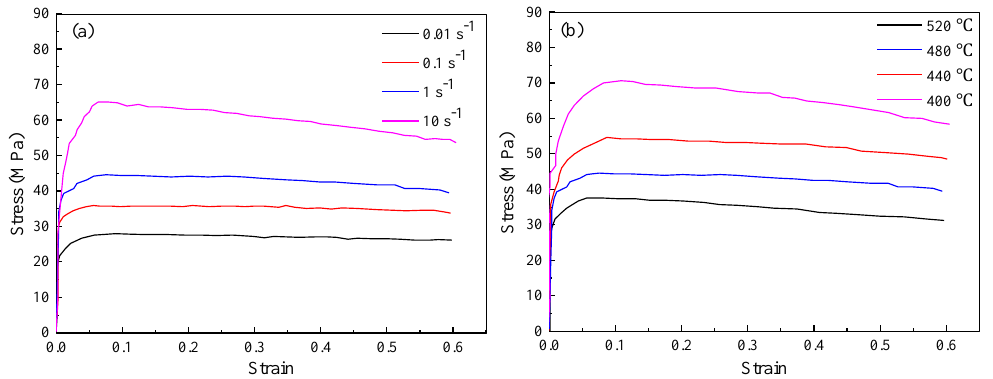
Figure 4. True stress–strain curves of AA6063 aluminum alloy: ( a ) at different strain rates in 480 °C; ( b ) at different temperatures in strain rate 1 s –1.